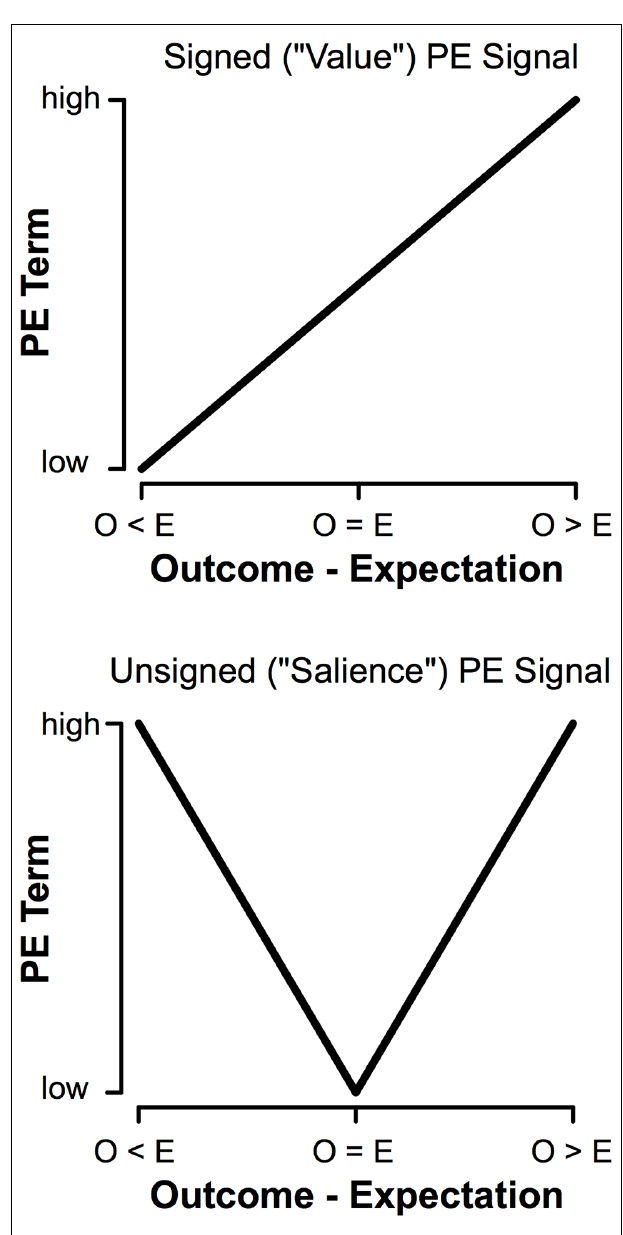
FIGURE 1 | Comparison of signed (“Value”) and unsigned (“Salience”) prediction errors (PEs). The main difference is in how the terms behave when outcomes are worse than expected (O < E); a signed prediction error will decrease with worse outcomes, whereas an unsigned prediction error will scale with increasing salience regardless of the value of an